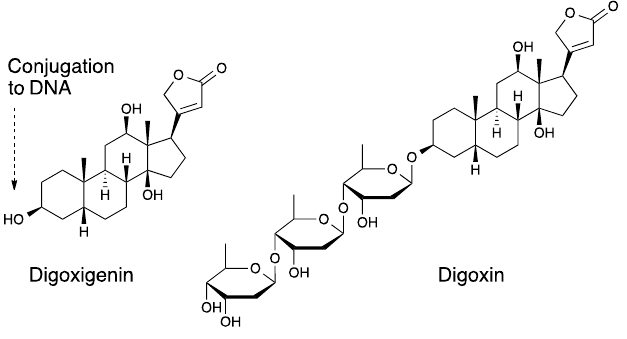
Figure 2. Digoxigenin and digoxin structure comparison. The OH group on digoxigenin is used for conjugation to the DNA B strand.